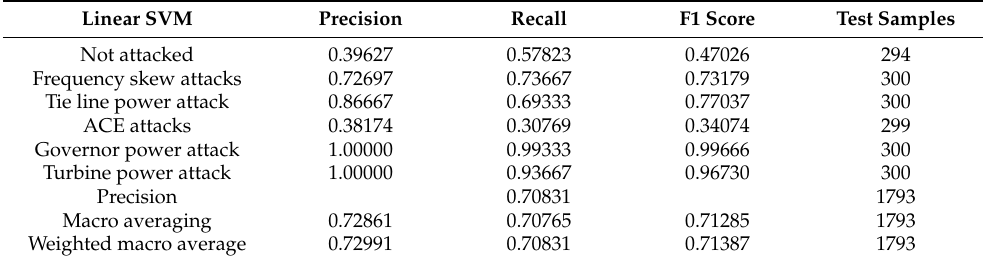
Table A3. The linear SVM algorithm trained on model indicator data.